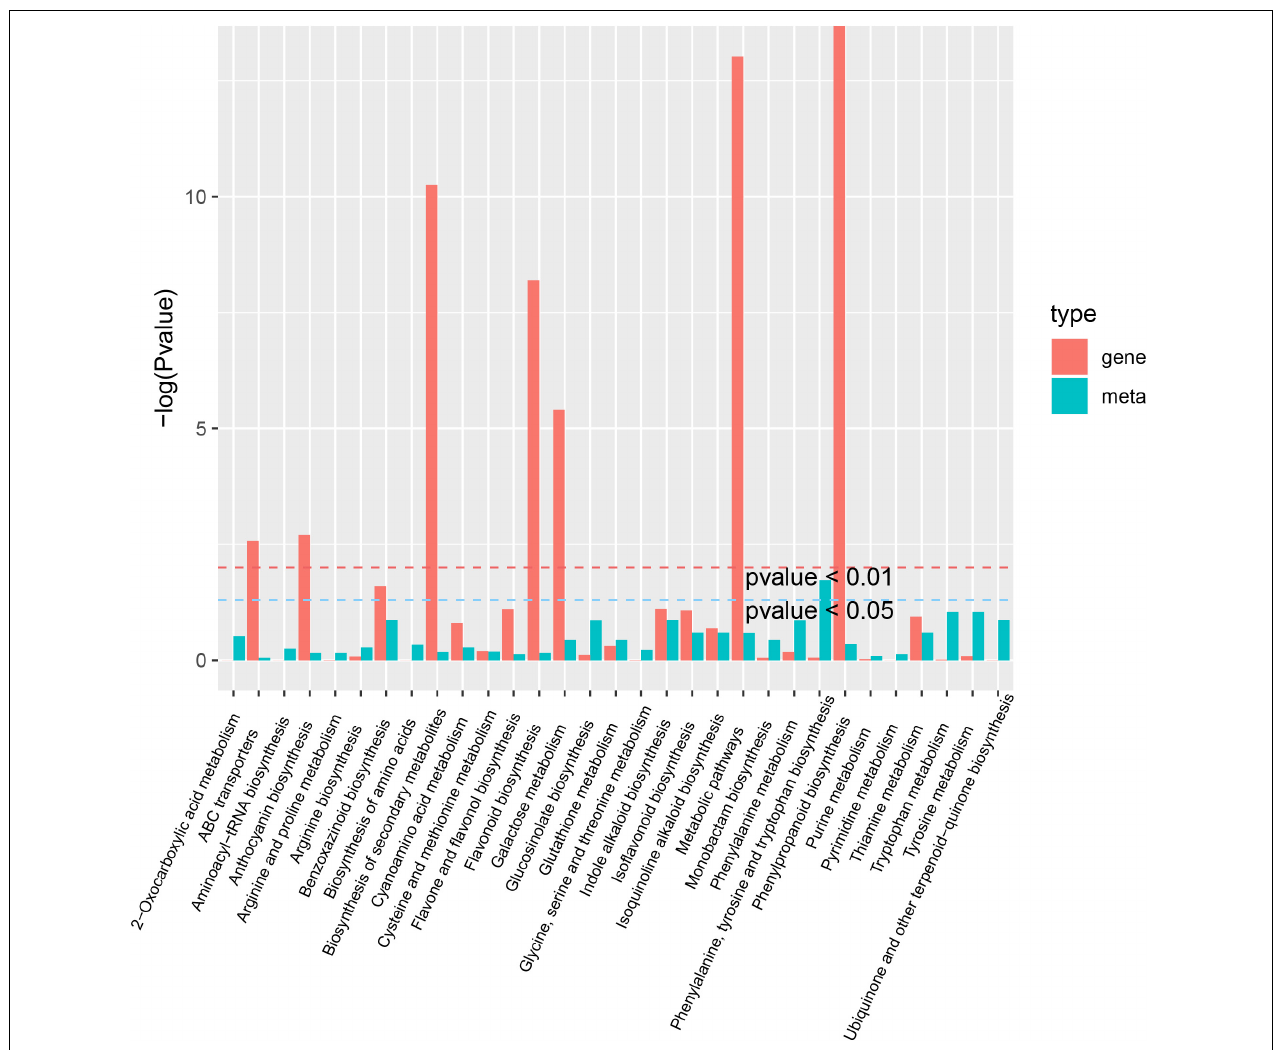
FIGURE 8 | Joint KEGG enrichment P -value histogram of A-J vs.